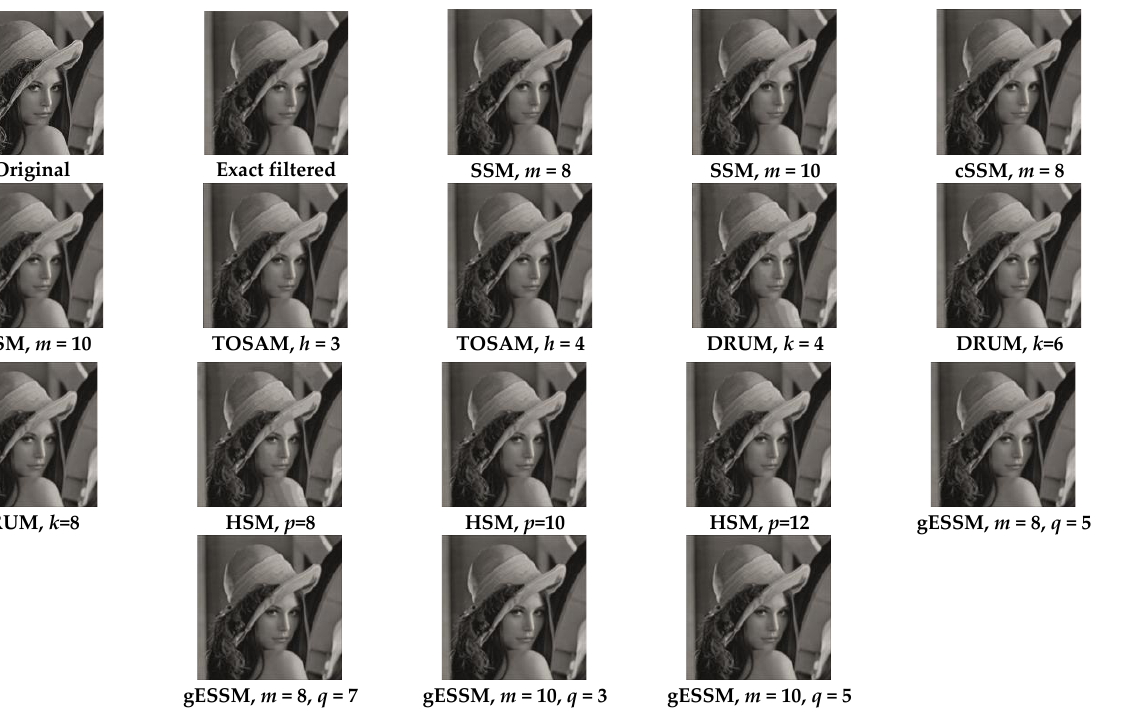
Figure 8. Lena image filtered by means of segmented multipliers.